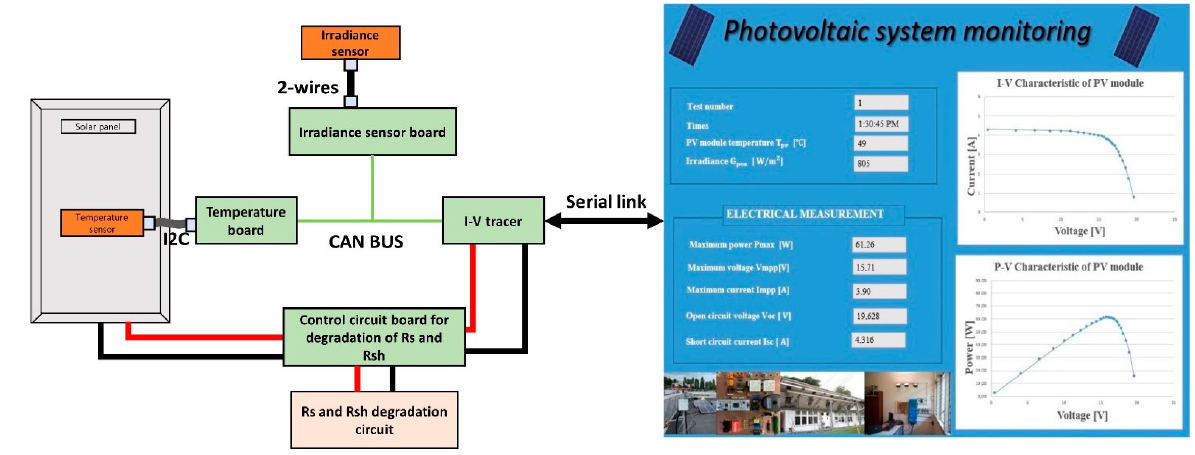
Figure 1. Schema diagram of the test bed.